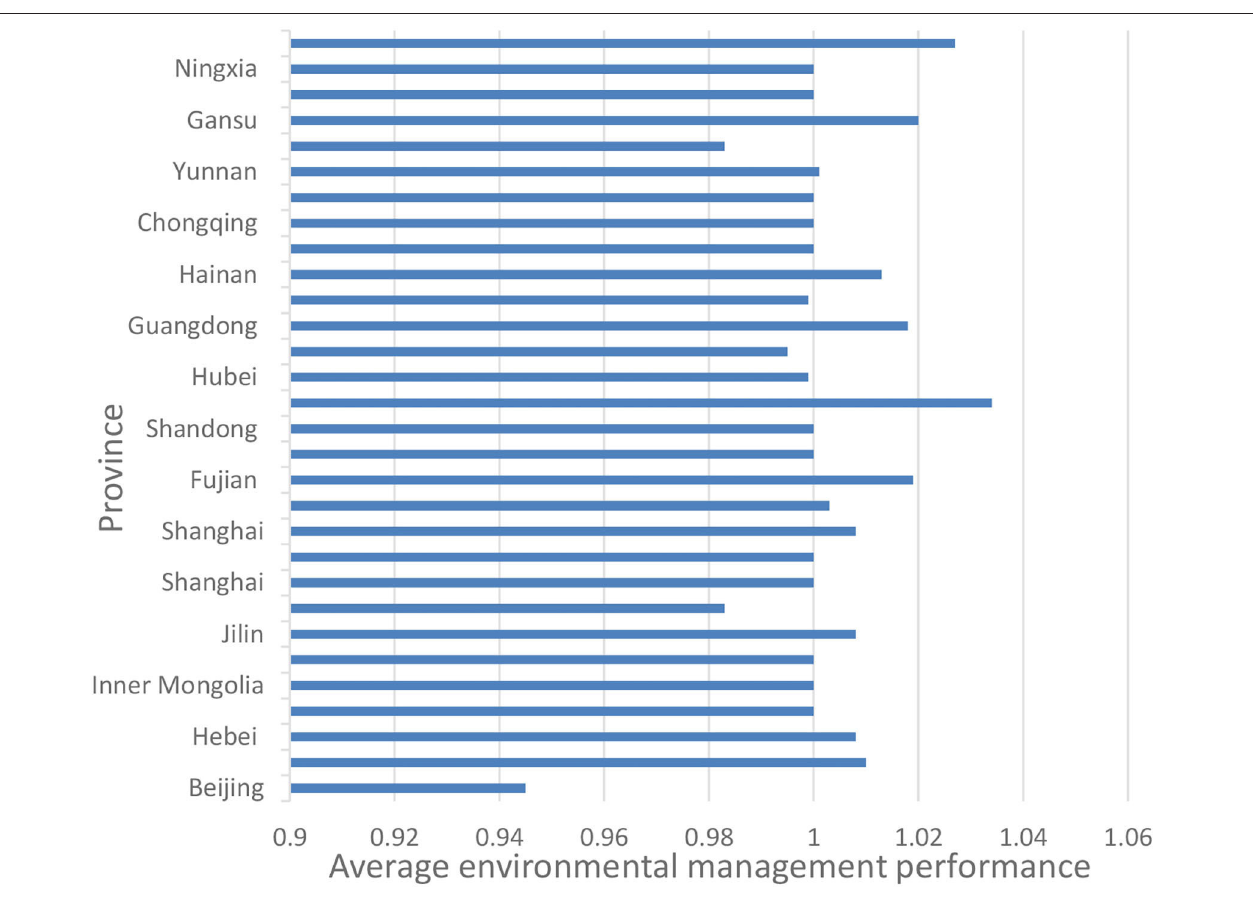
FIGURE 1 | Average environmental health index of each province from 1996 to